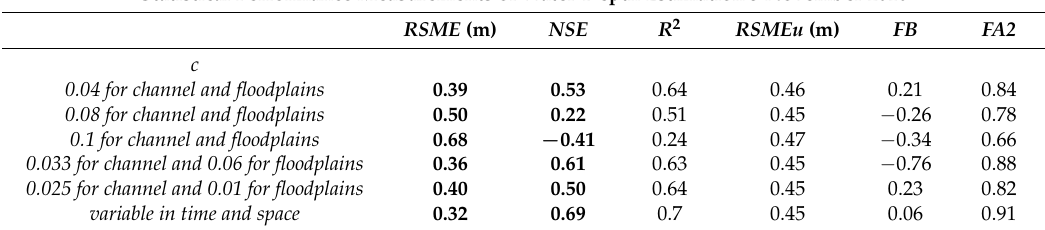
Table 5. Results of the calibration performance of the hydraulic simulation model for 3 November 2010: the relative value of Manning coefficients c , Root Mean Square Error RMSE , Nash- Sutcliffe Efficiency Coefficient ( NSE ), coefficient of determination R 2 , Unsystematic RSME RSMEu , fraction bias FB, prediction within a factor of two of observation FA2